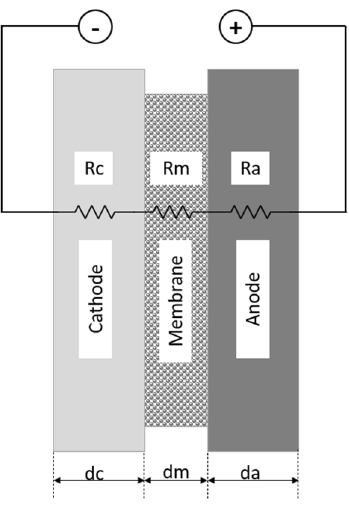
Figure 5. Model assumption for the determination of thermal resistance of the PEM electrolyzer.